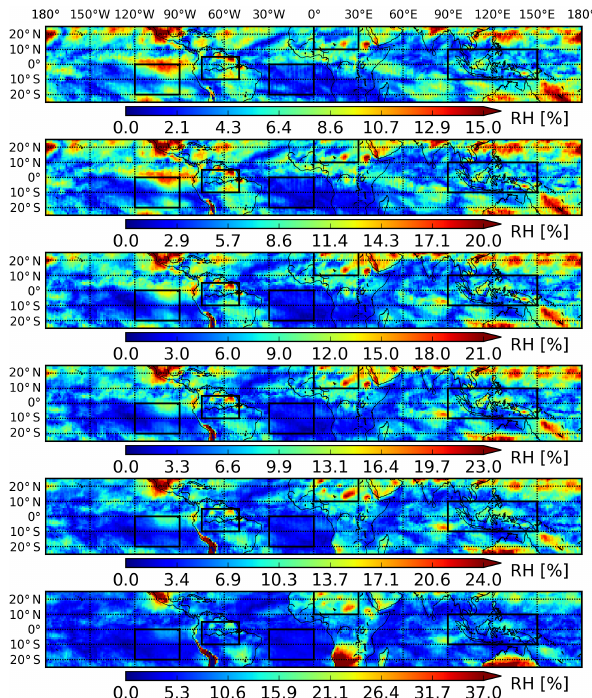
Figure 12. Spatial distribution of diurnal amplitude of RH I for the months of June and July. Depicts from top to bottom are for SAPHIR channels 1–6, respectively.